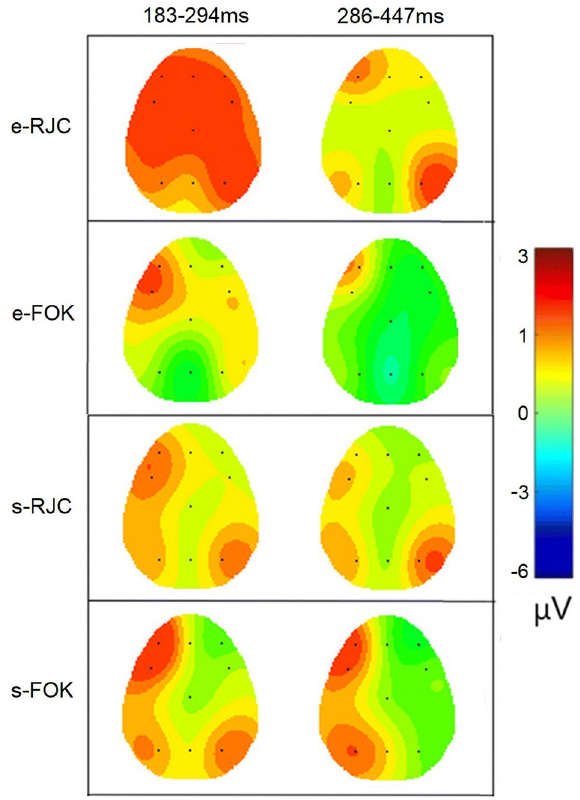
Figure 5. Head map of the cluster-based permutation tests that were conducted between 50 and 900 ms during episodic (top) and semantic (bottom) memory tasks for RCJ (top) and FOK (bottom) decisions. For each task and decision, the topographic distribution was plotted in two significant time windows, 183–294 ms (left column) and 286–447 ms (right column).